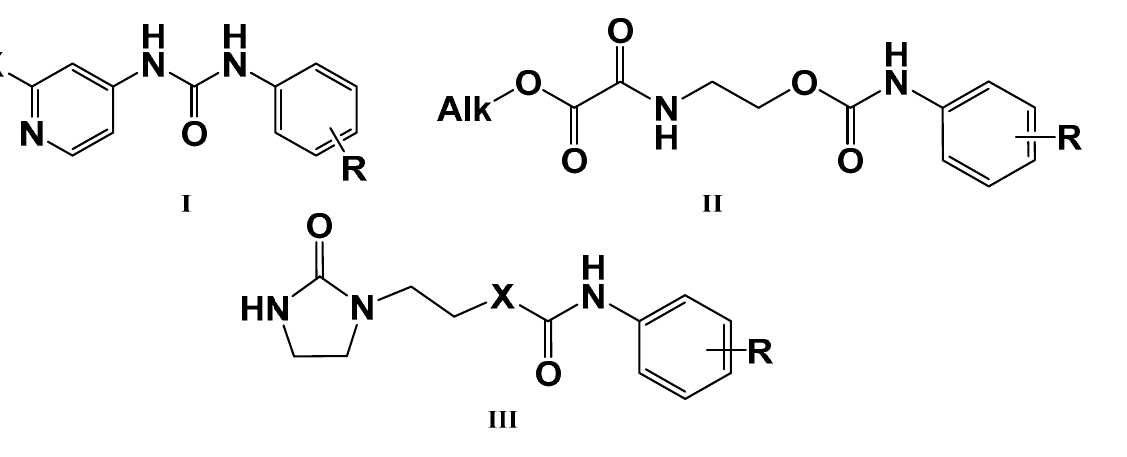
Figure 1. Cytokinin-like compounds. Cytokinin-like phenylureas bind to the same site as cytokinin receptors [15], are